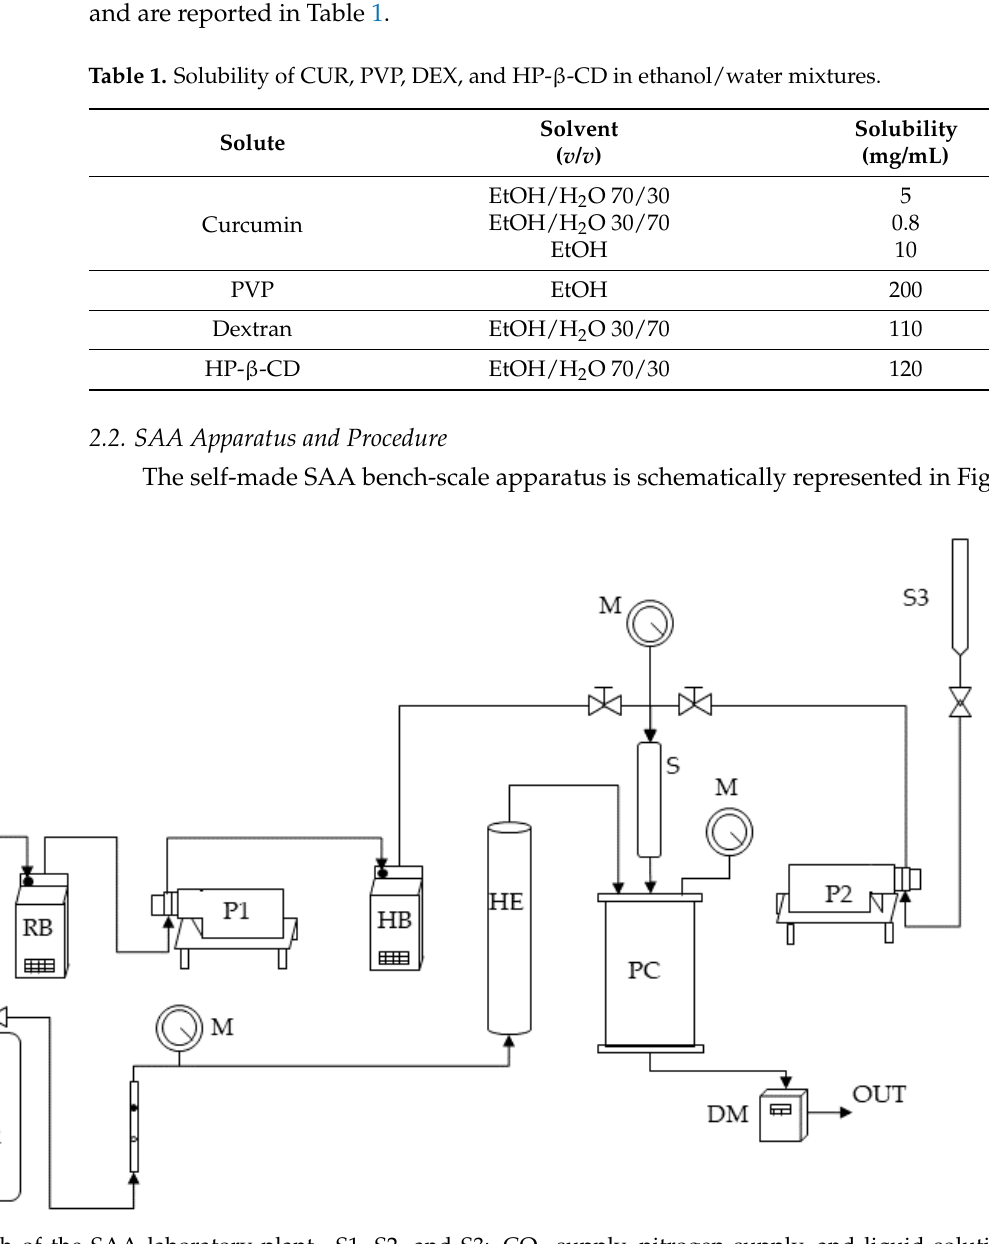
Figure 1. A sketch of the SAA laboratory plant. S1, S2, and S3: CO 2 supply, nitrogen supply, and liquid solution supply; P1 and P2: pumps; RB: refrigerating bath; HB: heating bath; M: manometer; HE: heat exchanger; S: saturator; PC: precipitation chamber; DM: dry test meter.